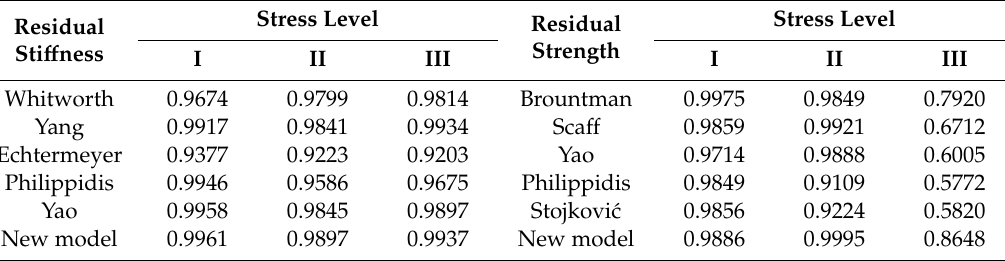
Table 3. Correlation coefficients of fatigue models at different stress levels.